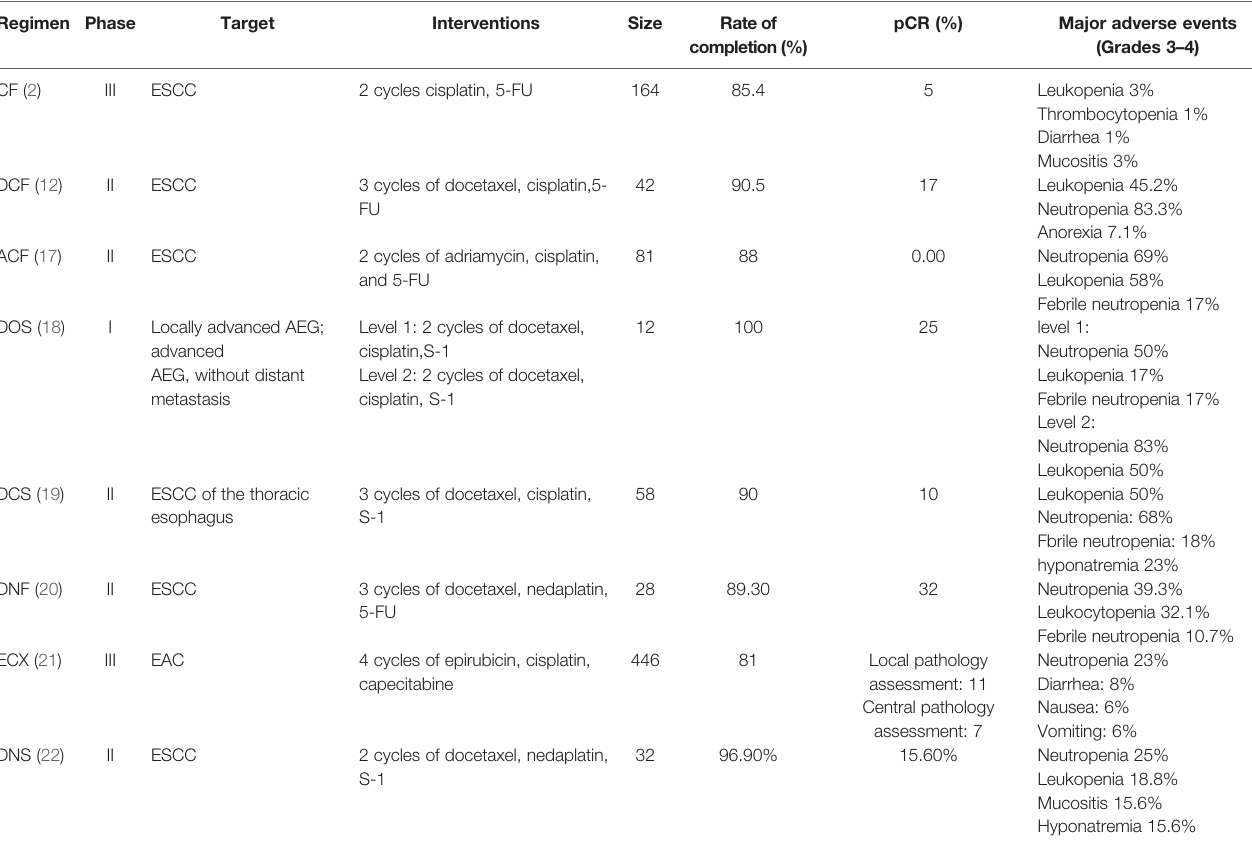
TABLE 2 | Main outcomes of studies regarding different regimens used in neoadjuvant chemotherapy. Regimen